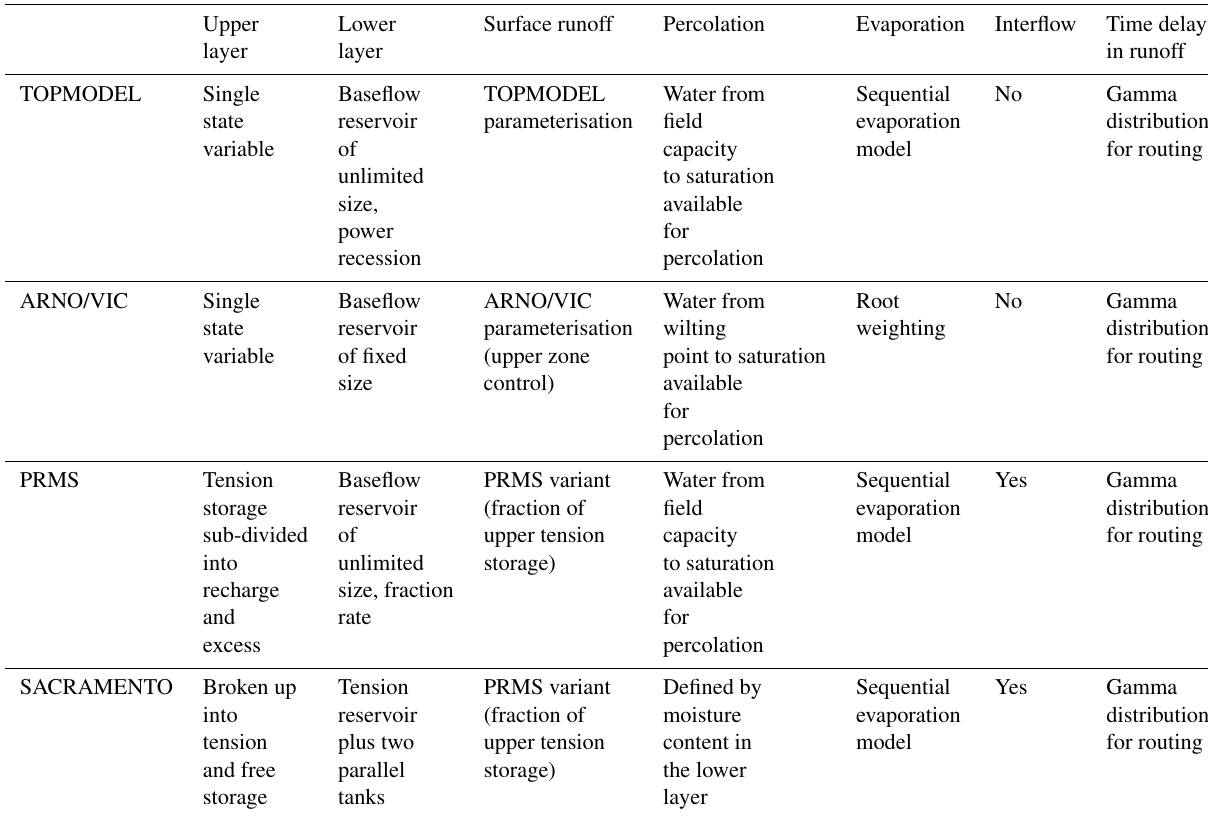
Table 3. Modelling decisions in the four parent models of the FUSE framework. A full description of the models can be found in Clark et al.